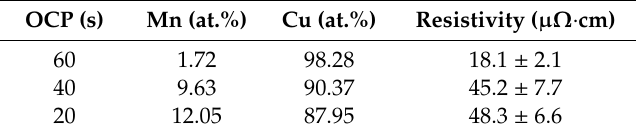
Table 2. Composition results of Cu(Mn) films deposited at their respective OCP